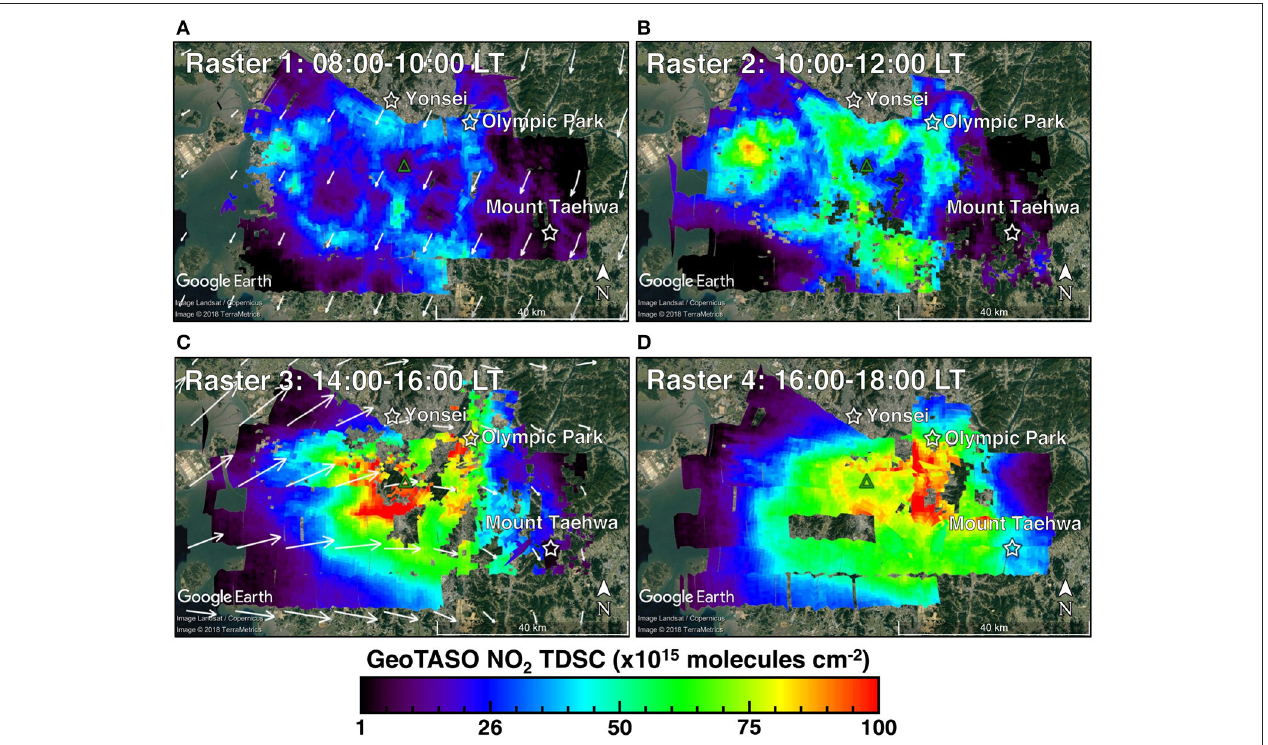
FIGURE 4 | Maps of GeoTASO NO 2 TDSCs over SMA on June 9th, 2016 for (A) Raster 1 from 08:00 to 10:00 LT, (B) Raster 2 from 10:00 to 12:00 LT, (C) Raster 3 from 14:00 to 16:00 LT, and (D) Raster 4 from 16:00 to 18:00 LT. Pandora sites are labeled with white star icons. Rasters 1 and 3 includes wind vectors (white arrows) averaged through the lowest 500m above ground level from the full resolution Global Data Assimilation System (GDAS) at (A) 00:00 UTC (09:00 LT) and (C) 06:00 UTC (15:00 LT).